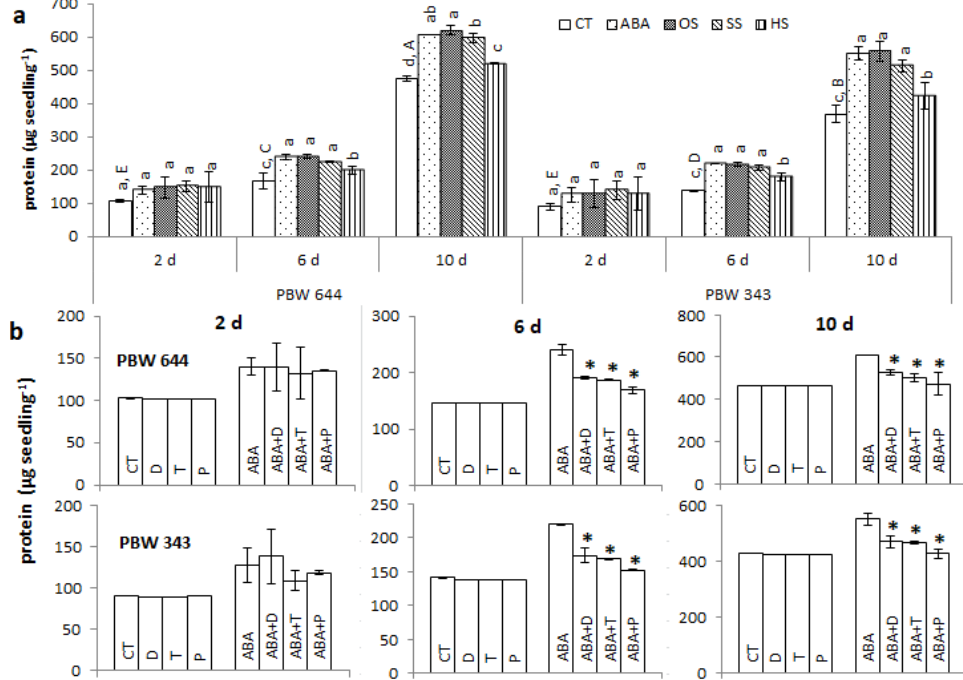
Figure 3 - Change of protein content ( a ) and ROS/NO regulation of protein ( b ) during post-germination desiccation and subsequent rehydration in wheat cultivars PBW 644 and PBW 343. Rest is same as in Fig. 1 for a and Fig. 2 for b .